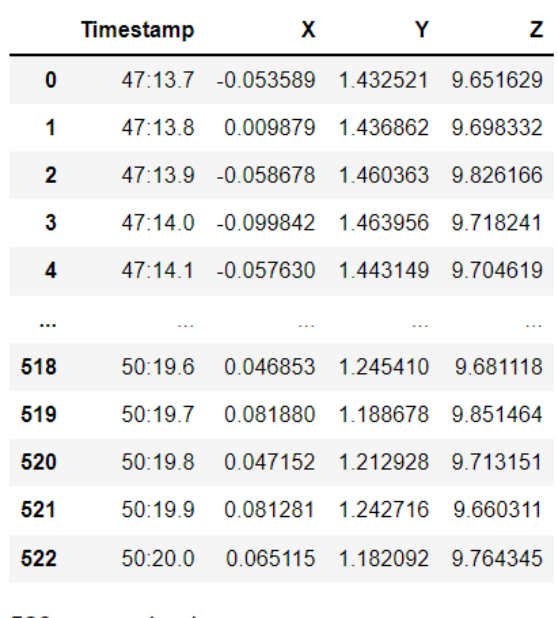
Figure 55. Merged acceleration sensor data.